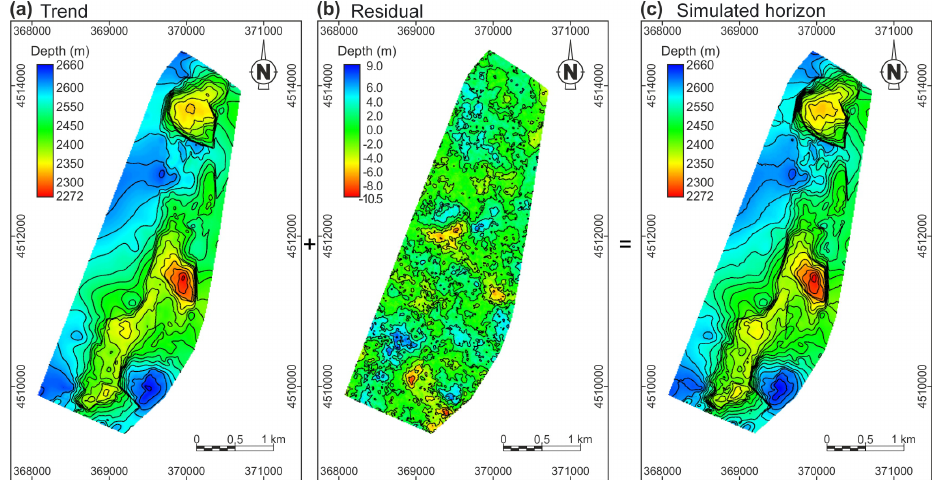
Figure 6. (a) Trend capturing the large-scale variation in the location and shape of the horizon. (b) Residual reproducing the small-scale or local variations between the trend and the unknown true depth of the horizon. (c) Simulated horizon that results from the sum of the trend and the residual. The example corresponds to the top of the Cretaceous. See also Fig. 7 for more